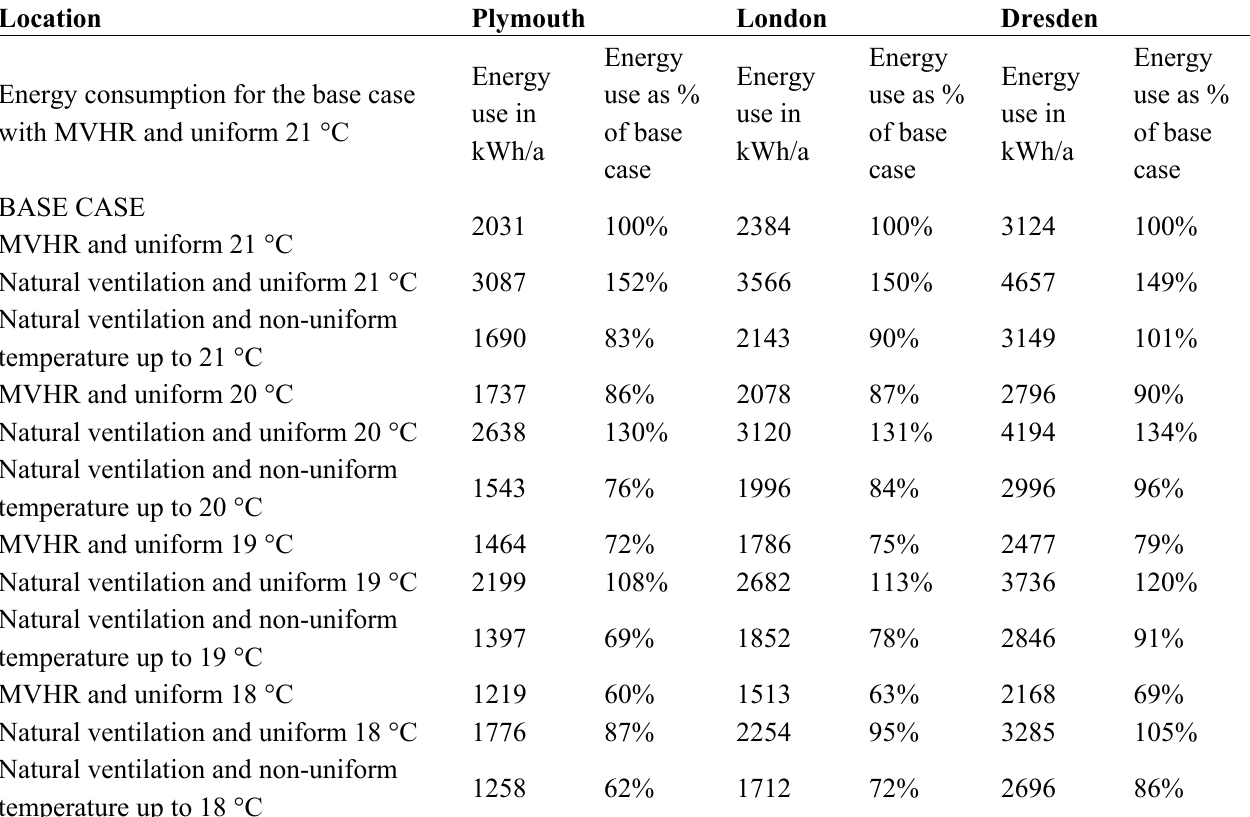
Table 3. Variations in energy use in kWhr per annum in different climates and as a percentage of the base case in each climate